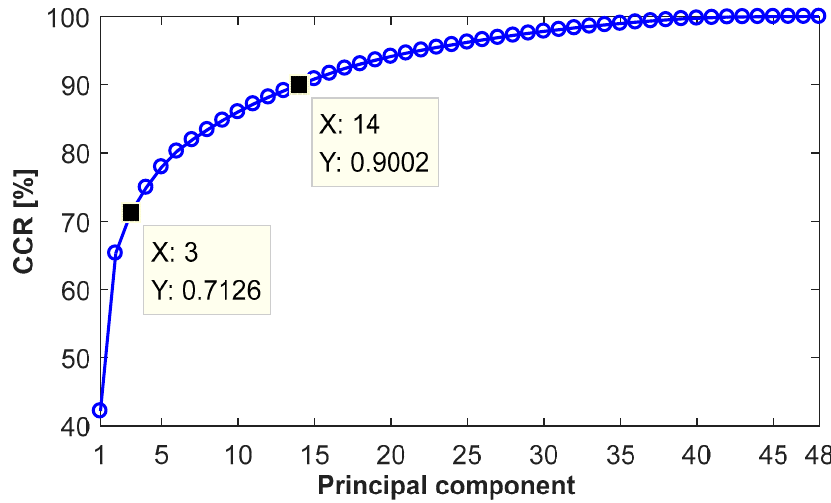
Figure 9. The cumulative contribution rate (CCR) with the increase of the principal components.